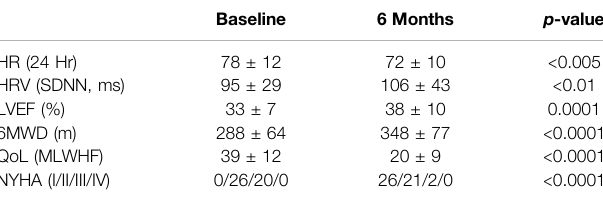
TABLE 3 | ANTHEM-HF Study results.